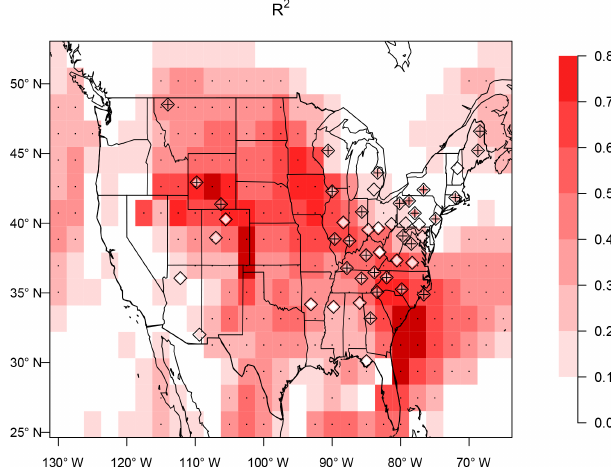
Figure 5. Interannual variance of MDA8 ozone explained ( R 2 ) by the linear regression model (Eq. 5) using the AWA projection value (Eq. 4) as the explanatory variable. Simulated variance is repre- sented in shades (as derived from simulated ozone and AWA in the GCM2000 simulation) and measured variance is shown in di- amonds (as derived from measured ozone at CASTNET sites and the ERA-Interim meteorology). Plus signs and stippling represent where R 2 is significant (at the 5% significance level) at CASTNET sites and model grids, respectively.